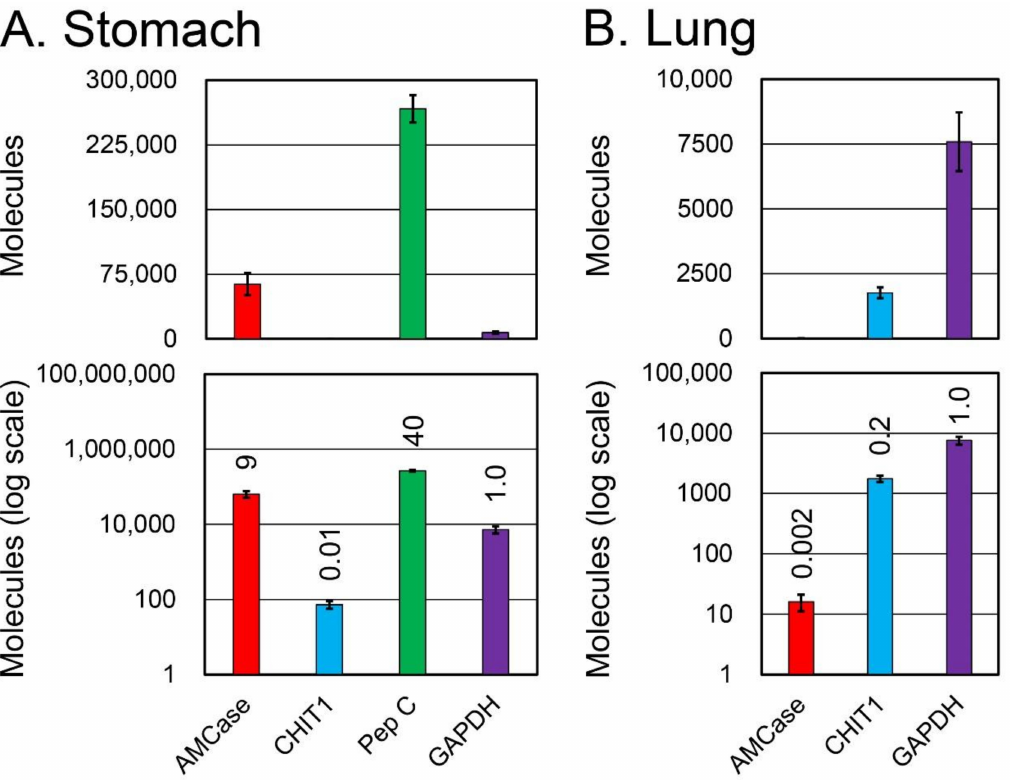
Figure 3. Analysis of AMCase and CHIT1 mRNAs and reference genes mRNA in stomach and lung tissues. Expression levels of the four genes determined using cDNAs prepared from normal crab-eating monkey ( A ) stomach and ( B ) lung were quantified by qPCR. The GAPDH expression level was set to 1.0; the values on the bars indicate the relative expression levels compared with that of GAPDH. Upper panel, actual value; lower panel, logarithmic